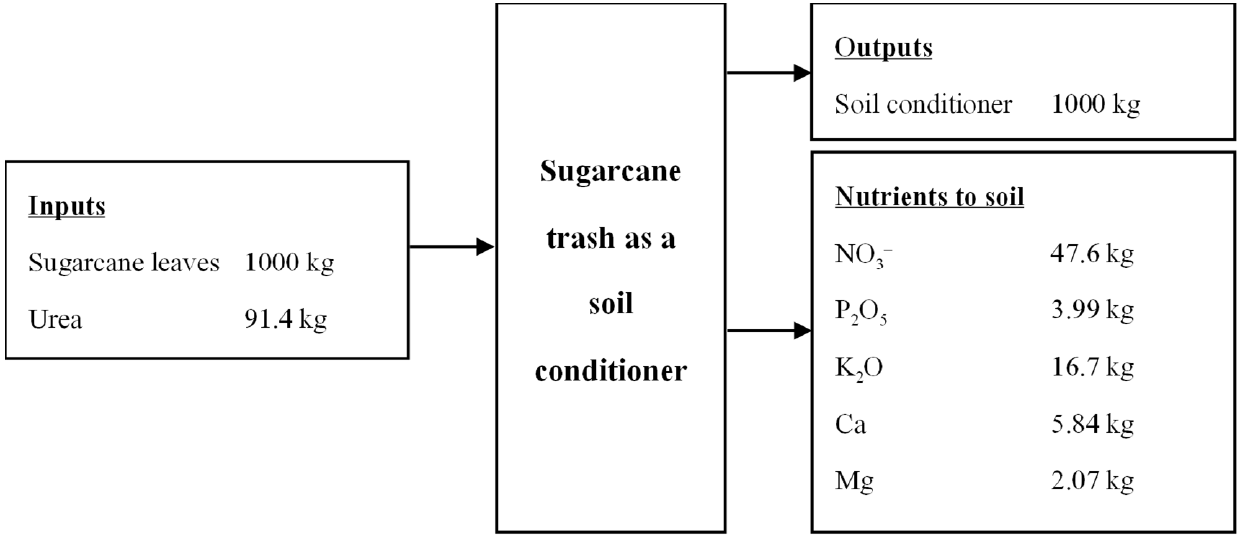
Figure A4. Inputs-Outputs of Scenario SL3: Cane trash as a soil conditioner. Remark: Production data is referred from [51]; Urea is referred from [65].